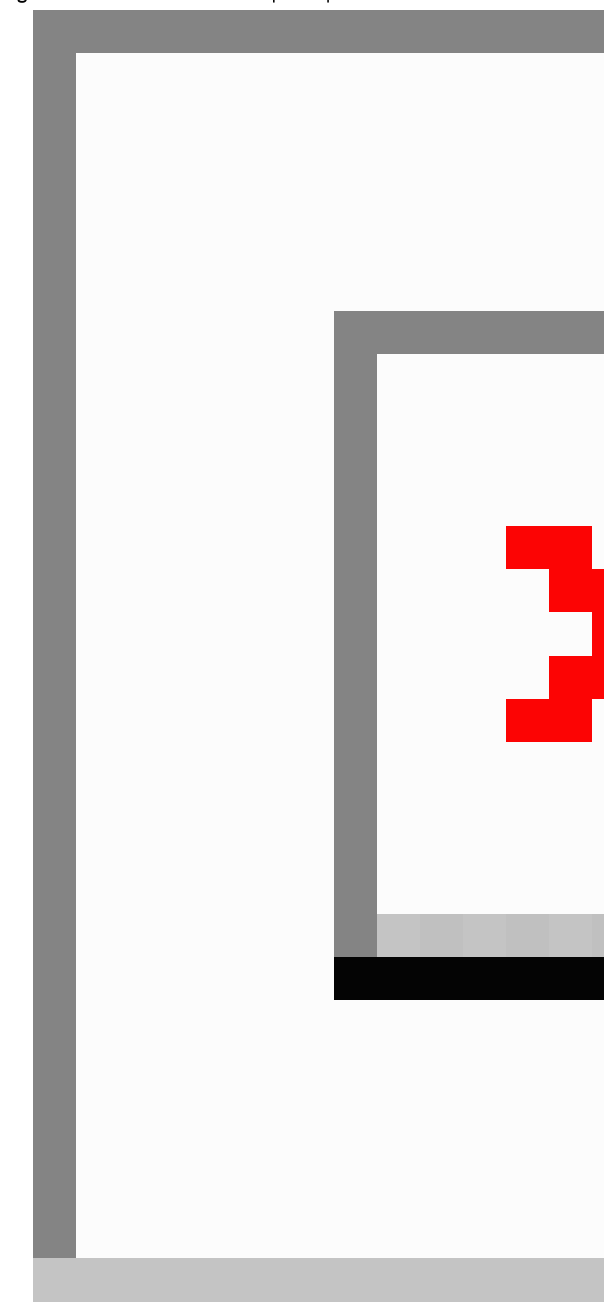
Figure 1. Consort flowchart of